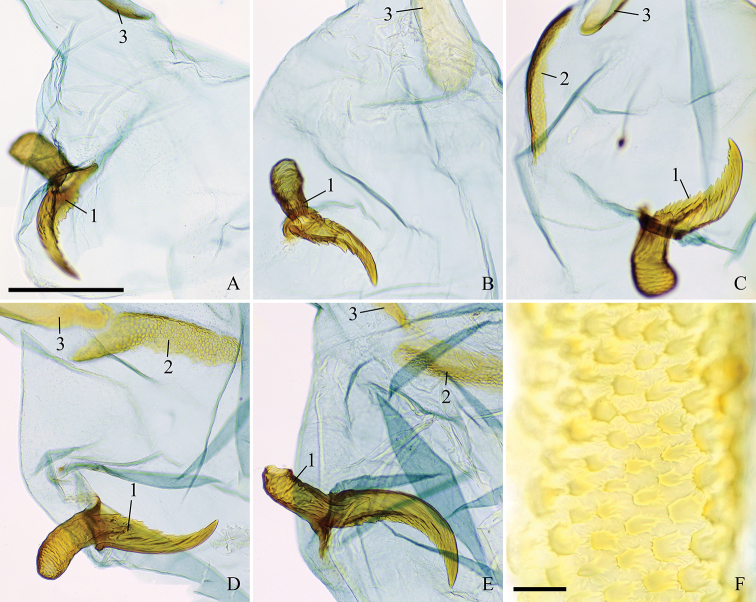
Signa of bursa copulatrix in Clepsis spp. AC.
neglectanaBC.
striolanaCC.
triviaDC.
consimilanaEC.
eatonianaF A detail of plate shaped signum of C.
consimilana consisting of sclerotised papillae. 1 falcate signum, 2 plate shaped signum, 3 cestum. Scale bars: 250 μm (A–E, all to scale), 25 μm (F).